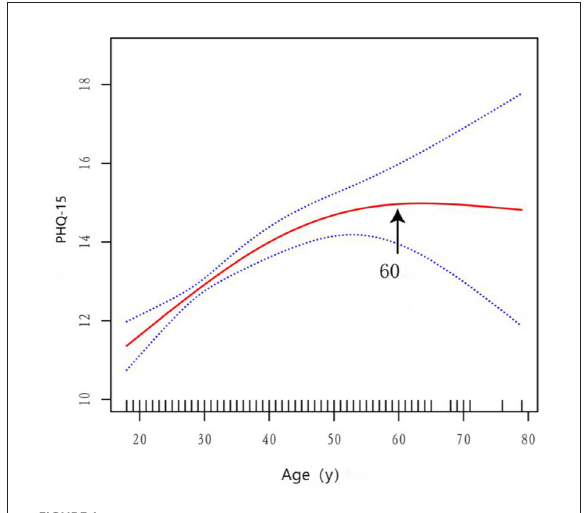
FIGURE1 Multivariable adjusted smoothed spline curve of age and MUS.